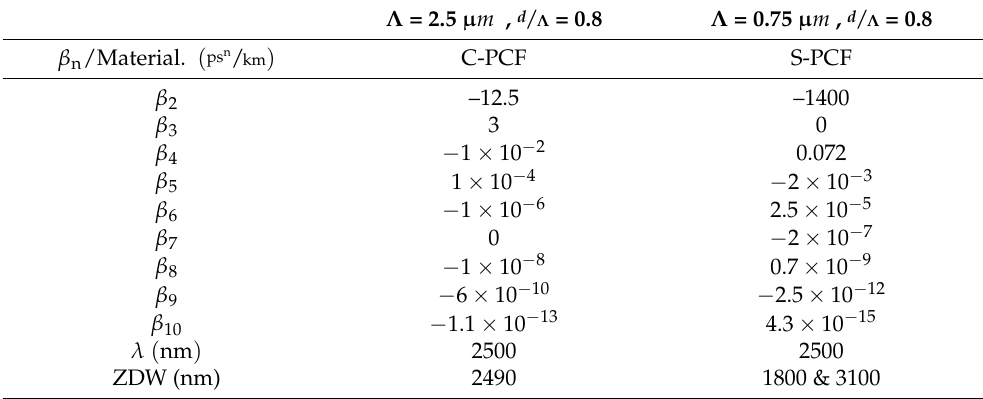
Table 1. The higher order dispersions coefficients of our proposed PCFs. Λ = 2.5 µ m , d / Λ =